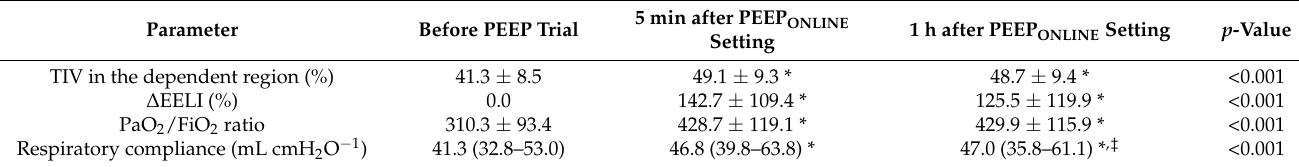
Table 2. Changes in respiratory and EIT parameters.